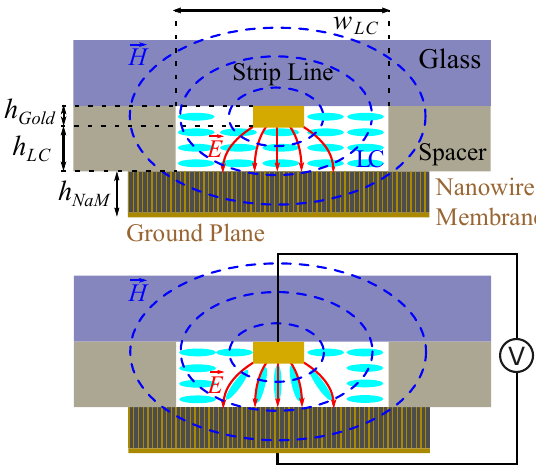
Figure 30. Cross-section of a slow-wave microstrip line and its working principle: unbiased, quasi-perpendicular orientation ( above ) and full-biased, parallel orientation ( below ). It is built up by a nanowire membrane (NaM) on top of the ground plane, where the space in between the NaM and the top substrate (glass) with the strip line is filled with LC. The parameters are h NaM = 50 µ m, h Gold = 2 µ m, h LC = 4 µ m, and w LC = 500 µ m [84].